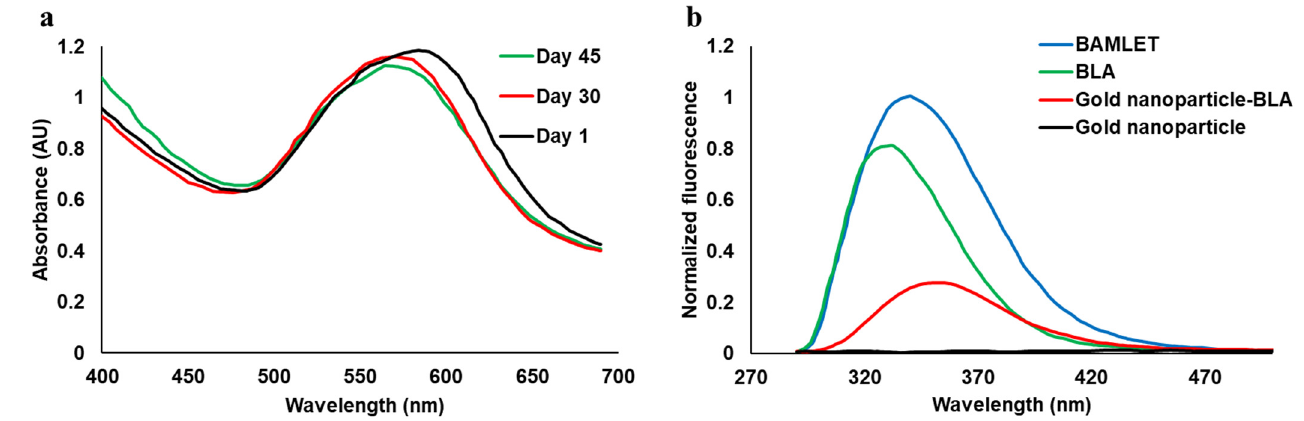
Figure 2. ( a ) Visible light spectra of gold nanoparticles measured over 45 days, proving their stability. ( b ) Tryptophan fluorescence emission spectra of BLA and the conjugates with tryptophan excitation at 280 nm.